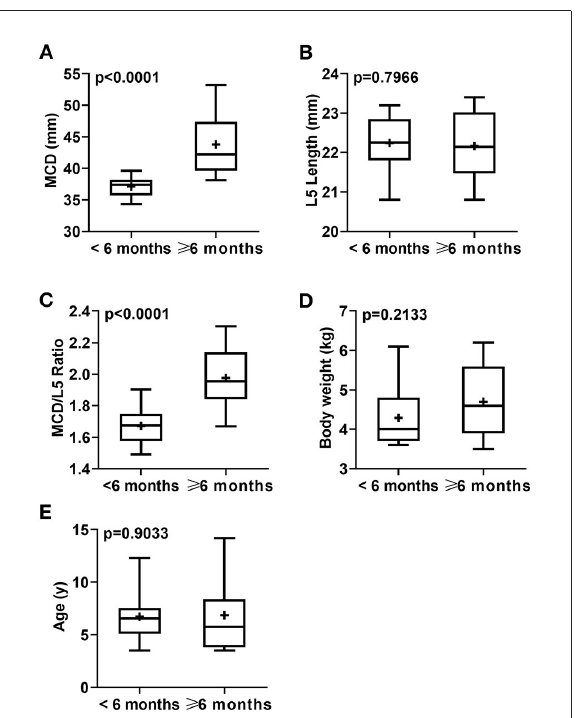
FIGURE4 Box-and-whiskers plots of MCD (A) , L5L (B) , MCD/L5L Ratio (C) , body weight (D) , and age (E) for cats that had confirmed idiopathic megacolon with a duration of constipation/obstipation < 6 months ( n = 12) or ≥ 6 months ( n = 18). The line represents the median, the cross represents the mean, and the whiskers represent the range. Significant at p < 0.0001 and p <